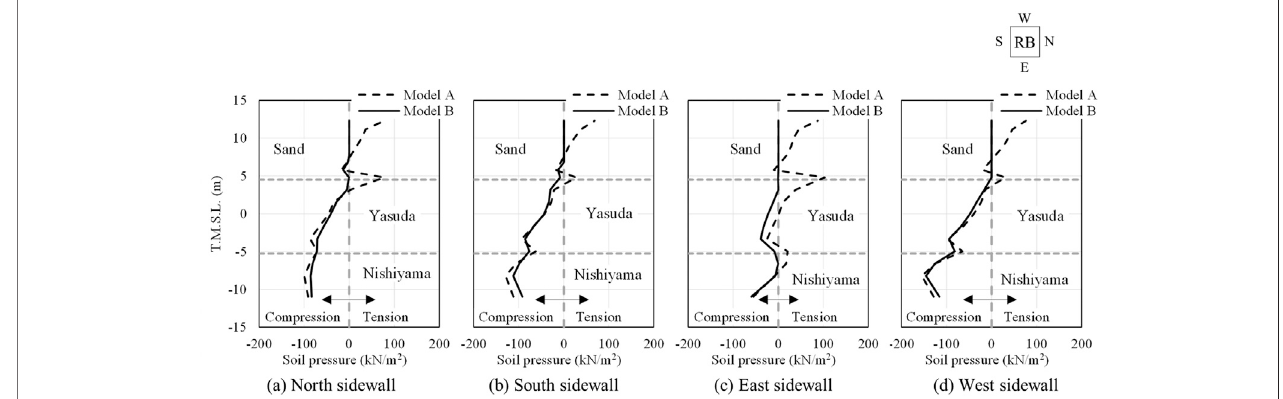
FIGURE 12 | Soil pressure characteristics at time of maximum tension acting on sidewalls.